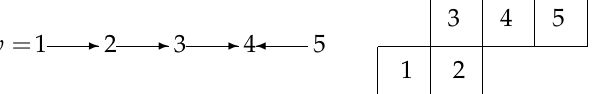
Figure 3. Snake graph G f ( 2,2,3 ) = G [ 4,2 ] associated with a four-arrow string. The string module M ( w ) over the corresponding Dynkin algebra of type A is obtained by replacing every vertex with a copy of a field F . In such a case, arrows correspond to identity